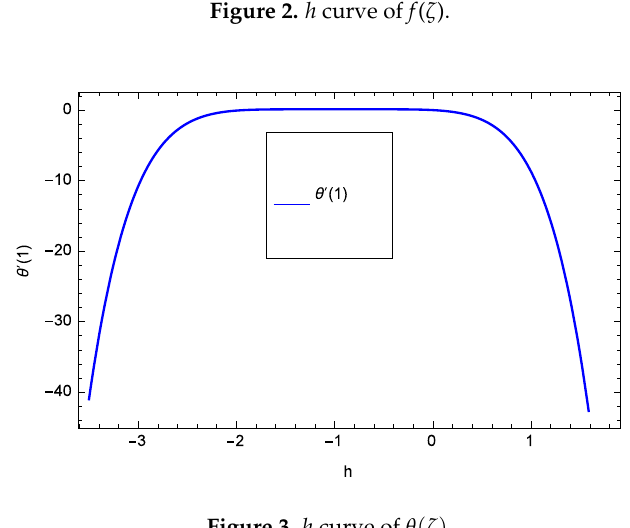
Figure 2. h curve of f ( ζ ).